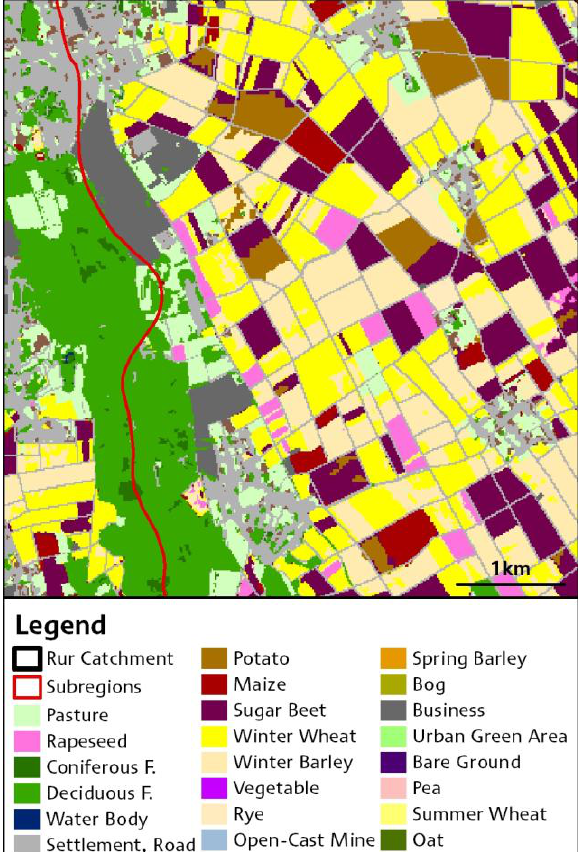
Figure 5. Subset of the MDA-LU dataset of 2008. Remote